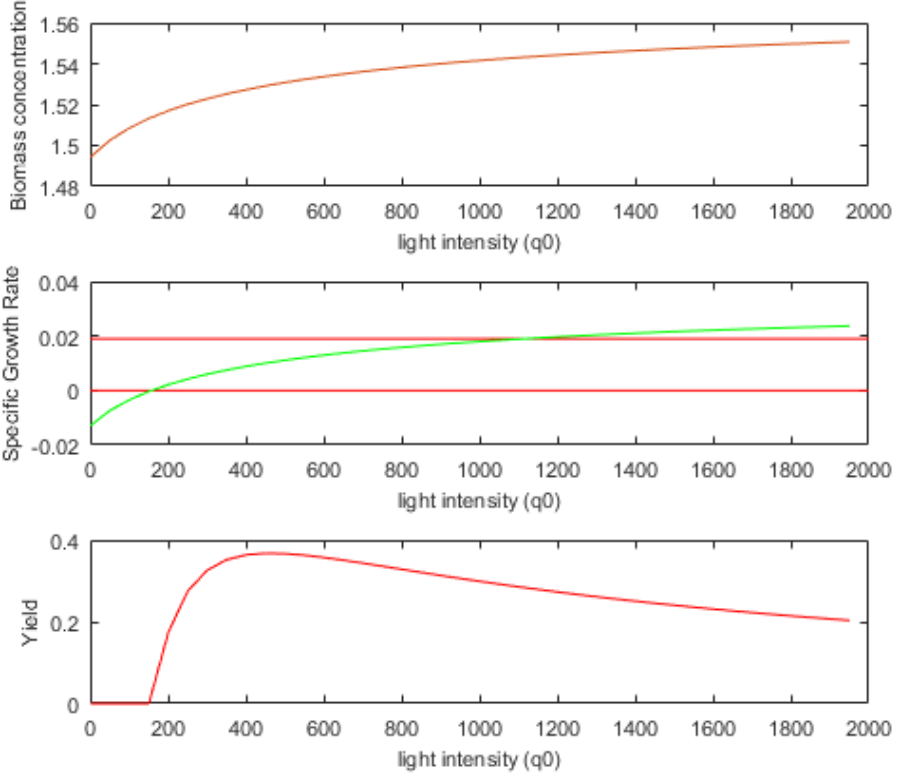
Figure 5. Dependence of biomass concentration, SGR, and biomass yield on light energy as a function of light intensity.